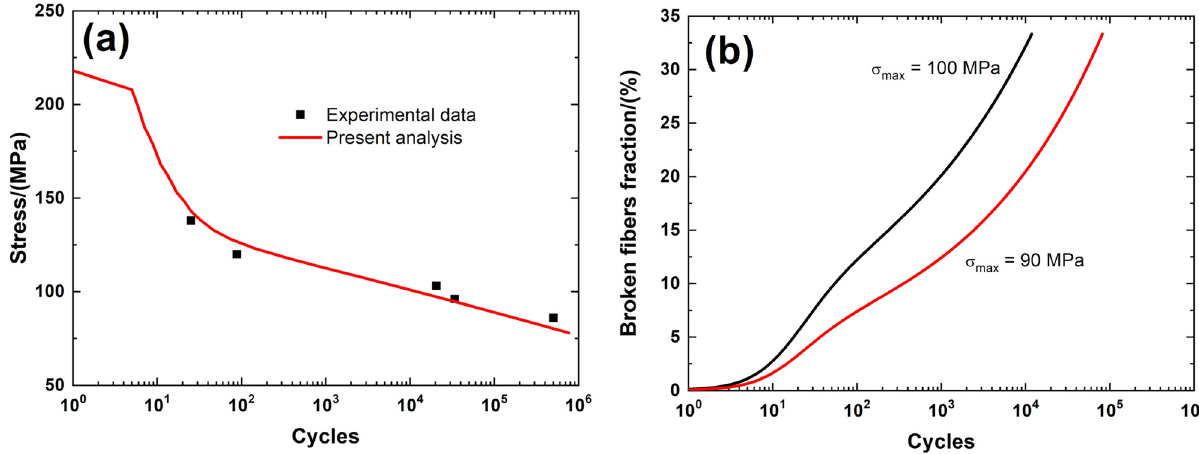
Figure 11: ( a ) Experimental and predicted fatigue life S – N curves, and ( b ) the FBFF versus applied cycles of cross - ply SiC/MAS composite under IF loading at 1,093°C in air condition.